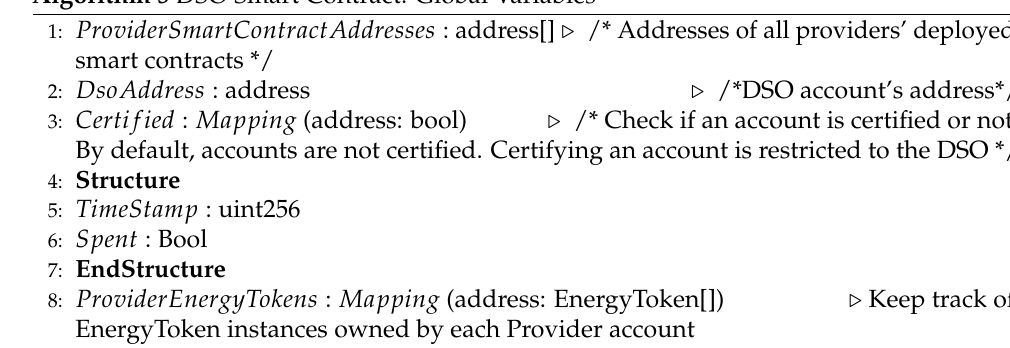
Algorithm 5 DSO Smart Contract: Global Variables